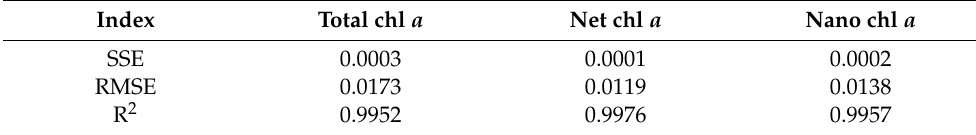
Figure 4. Comparison between measured and predicted values of chlorophyll a for each size class from ( a ) site A, ( b ) site B, and ( c ) site C. Table 2. Statistical results for the validation of the artificial neural network